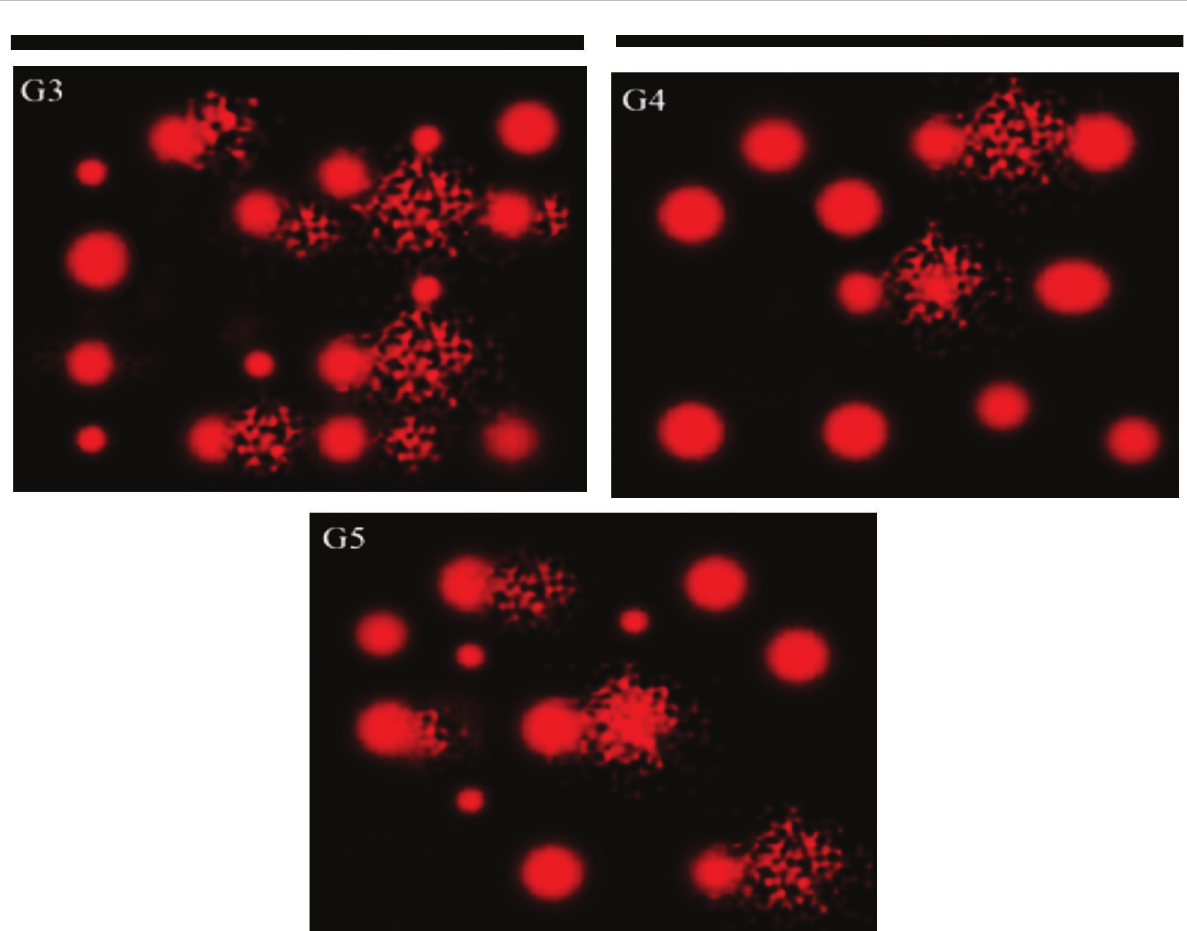
FIGURE 1 - Comet assay for DNA damage in liver tissues in different groups under study. Where G1, control group; G2, costus group; G3, Ethephon group; G4, Ethephon then costus group; G5, Ethephon then self-healing group.